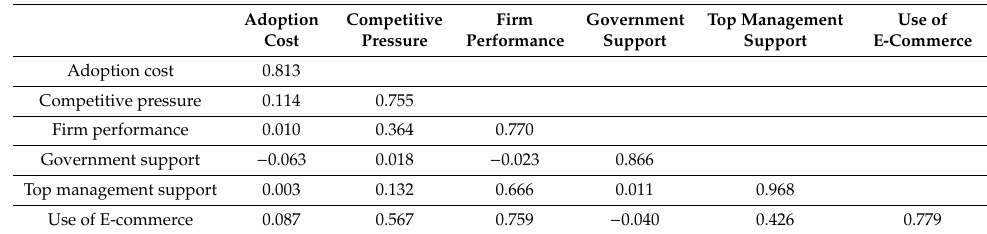
Table 8. Discriminate validity matrix.